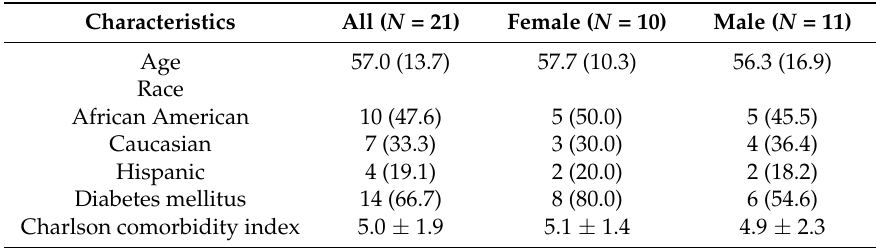
Table 1. Characteristics of participants.